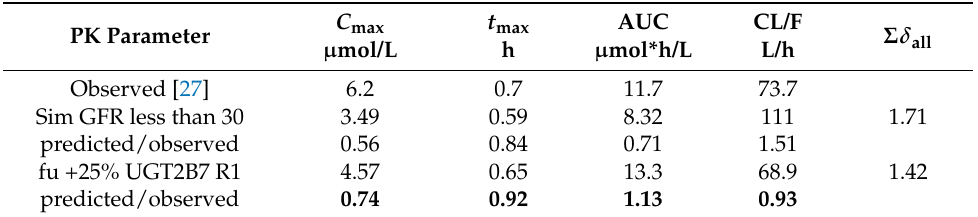
Table 3. Comparison of Predicted and Observed Values for Pharmacokinetic Parameters for Zidovudine in Severely Renally Impaired Patients.